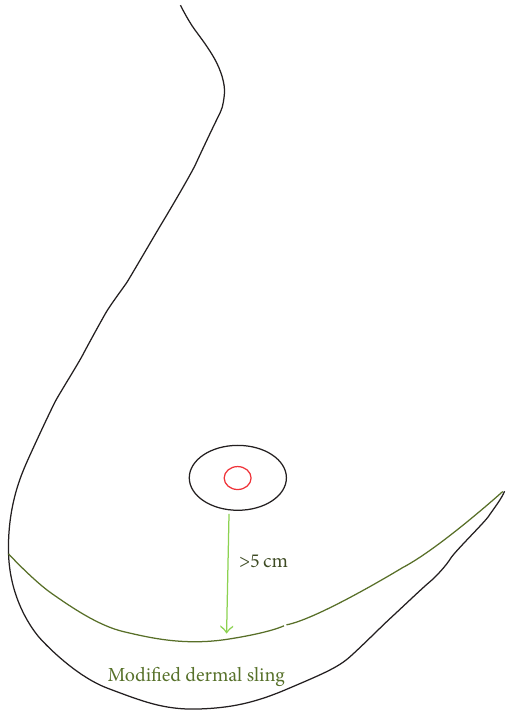
Figure 1: Schematic diagram to show the creation of modified autologous dermal sling (crescent shaped) ensuring the new infra- areolar to inframammary crease distance of at least 5